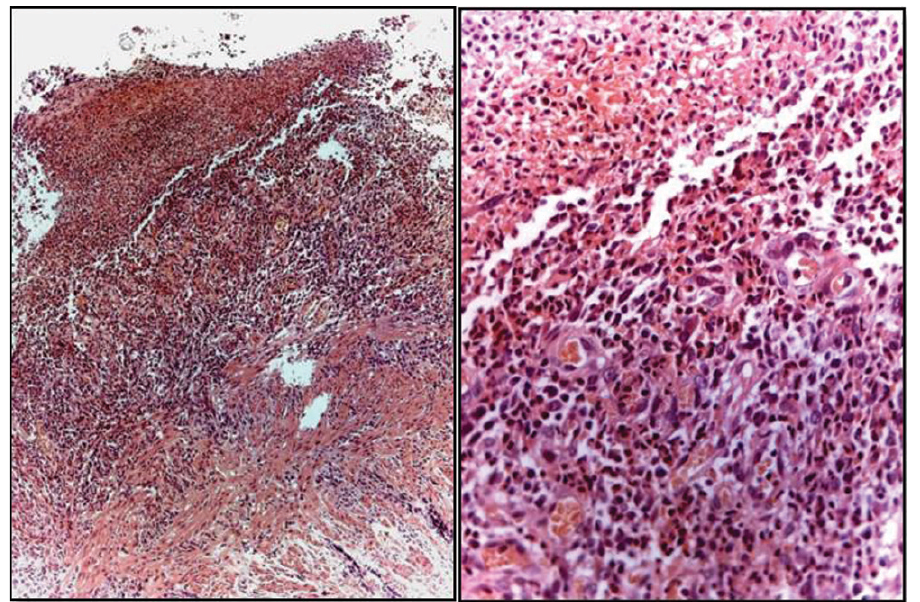
Figure 4 - Acute inflammation with erosions. There are erosions in the muscular layer of the mucosa, a fibrin-leukocyte buffer and adjacent